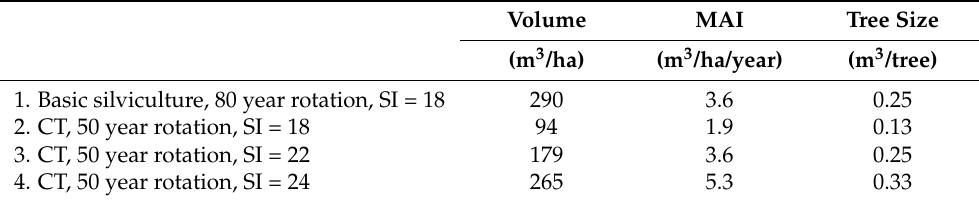
Table 1. Volume estimates for basic and intensive silviculture scenarios of white spruce. Volume MAI Tree Size